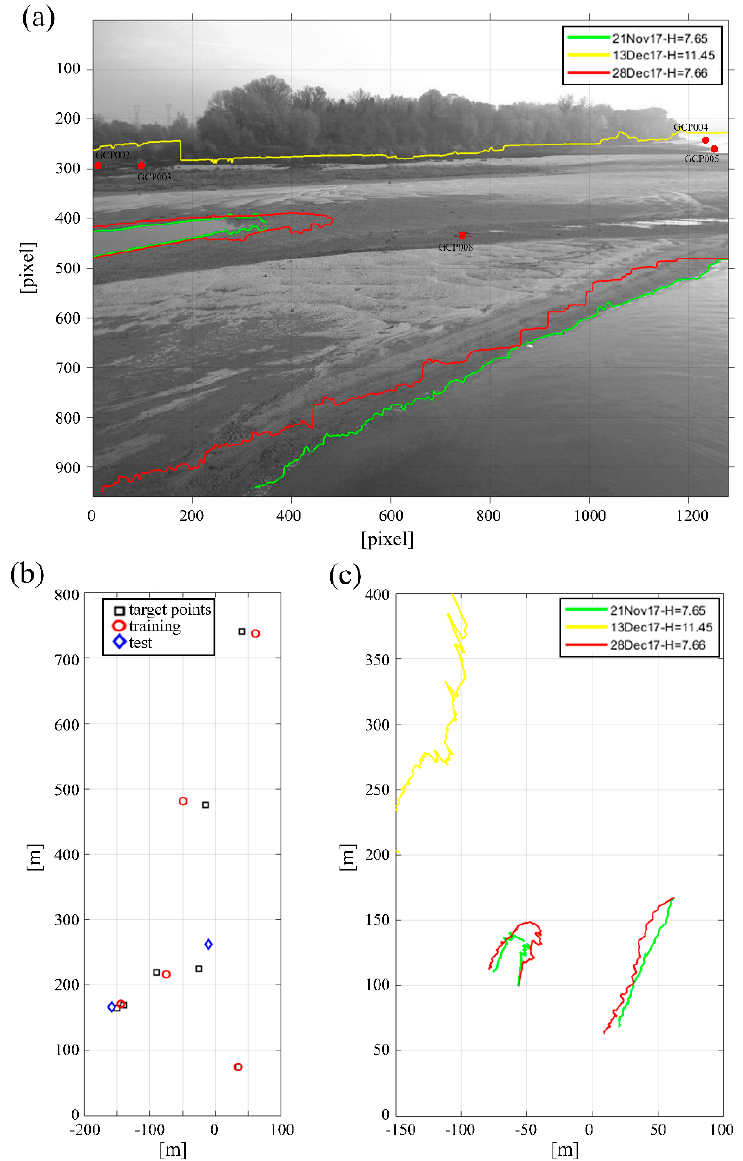
Figure 2. ( a ) Example of edge-of-water line tracking on the original image and location of some ground control points. ( b ) The two-steps method for the homographic transformation between image and real plane coordinates. ( c ) Example of corrected edge-of-water line positions.